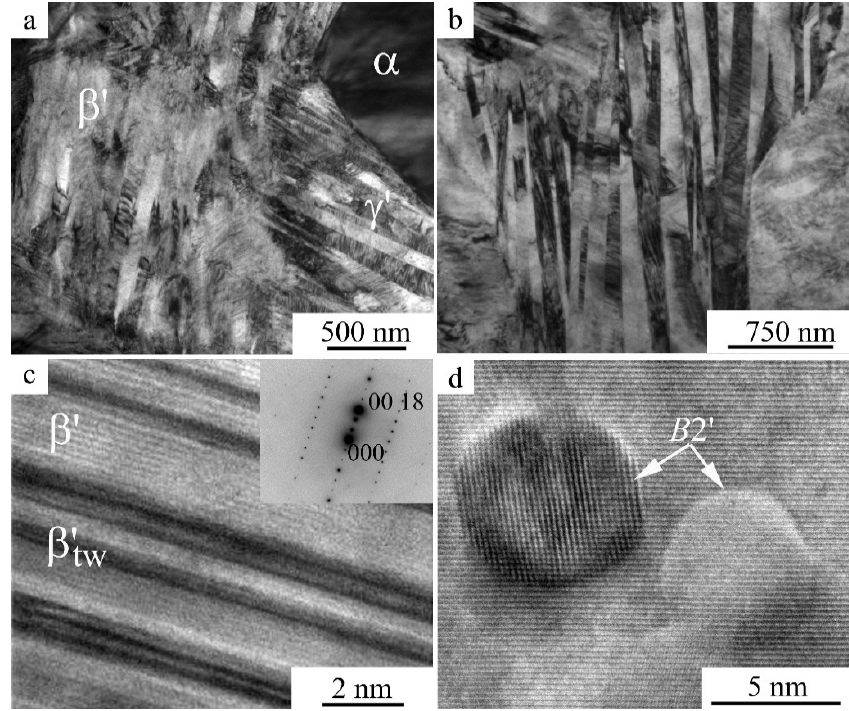
Figure 9. ( a , b ) Bright-field TEM images (amplitude contrast) and ( c , d ) high-resolution TEM images (phase contrast) of ( a – c ) the martensite microstructure and ( d ) B 2 ′ phase particles after compression tests at ( a , c ) 873 K, ( b ) 973 K, and ( d ) 673 K. Figure 10 shows TEM images of the fine structure of α , γ 2 , and B 2 ′ particles after MPC at 773 K. As follows from their analysis, the grains and crystallites of the α phase formed inside the β 1 matrix in the course of the compression tests experienced noticeable plastic deformation, with the formation of mesh–cellular dislocation and twin substruc- tures (see Figure 10a,b), in contrast to the more brittle, solid, and often twinned γ 2 phase (see Figure 10c,d). In addition, B 2 ′ phase rounded precipitates based on the Ni-Al system were observed (shown by arrows in Figure 10c,d), which had much smaller dimensions (not exceeding 100 nm), and formed in the initial austenite, at the boundaries, and inside the α and γ 2 inclusions . According to X-ray energy-dispersive elemental microanalysis, in agreement with the data [4], α crystals were somewhat depleted of aluminum (after the alloy’s offsetting at 673 and 773 K to 10 wt.%), and γ 2 precipitations—along with cop- per—contained up to 5 at.% Ni, whereas B 2 ′ precipitates—along with nickel and alumi- num—contained up to 5 at.% Cu.